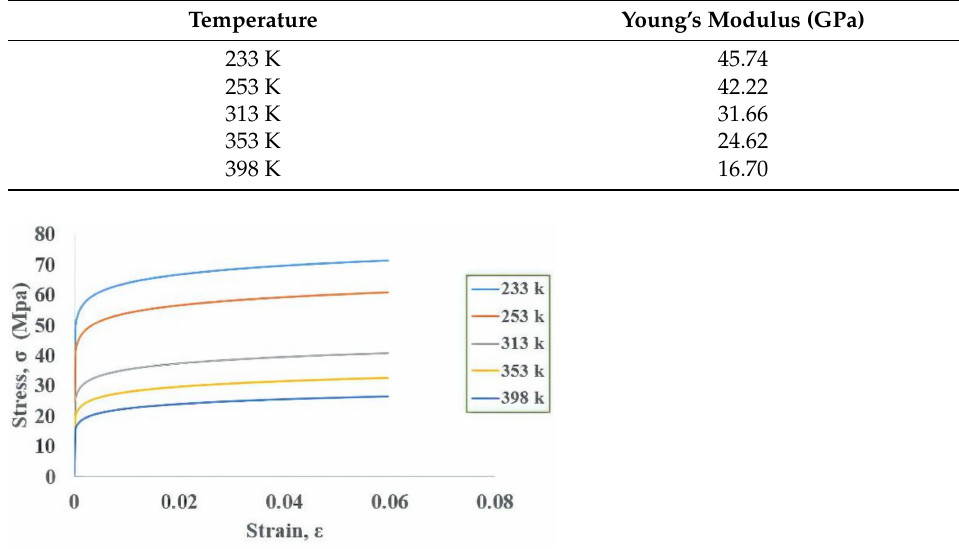
Figure 3. Stress–strain curve for SAC solder.